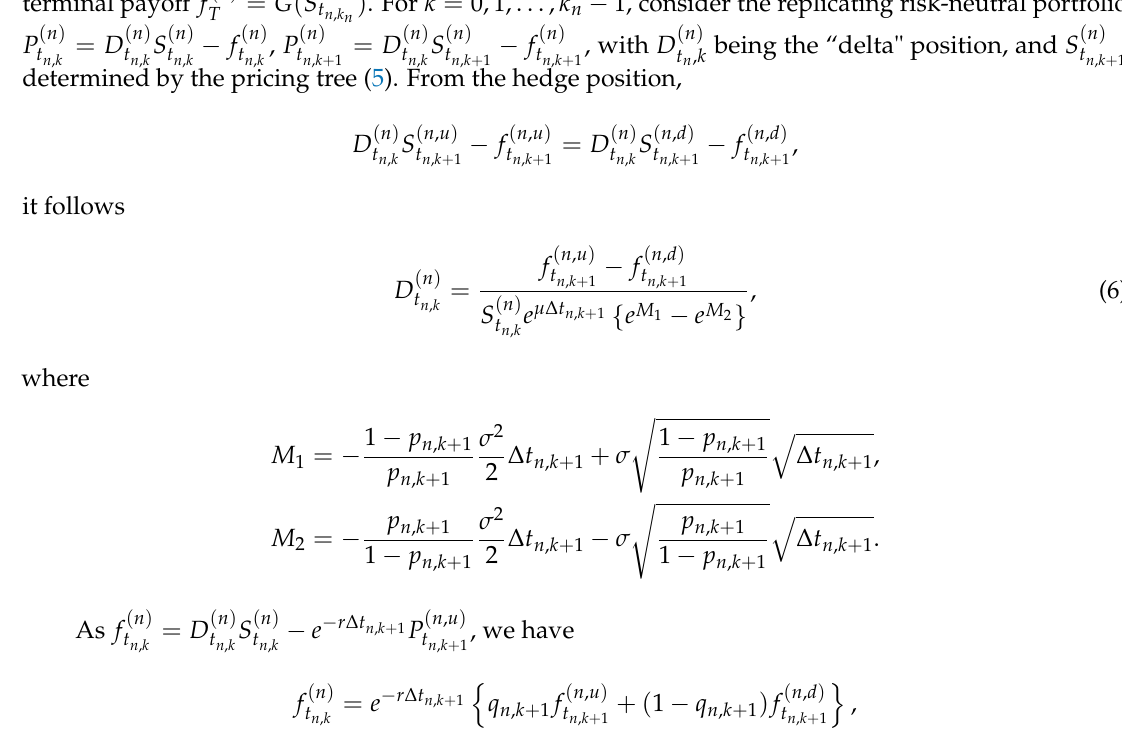
The plots: indicate there is insufficient evidence to reject H 0 at the 0.05 significance level for weekly intervals; imply rejection of H 0 in most monthly intervals; and imply rejection of H 0 in all yearly